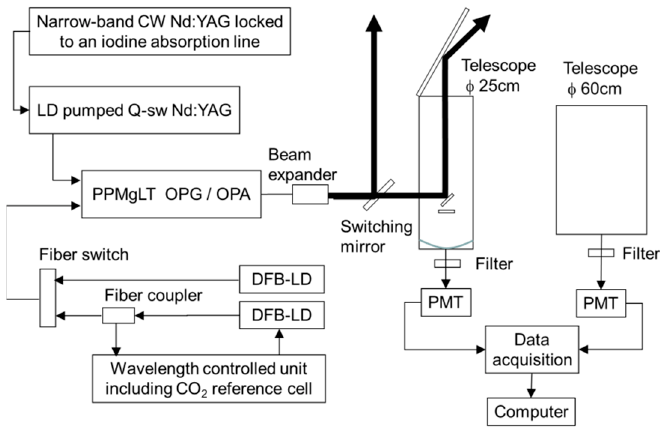
Figure 2. Block diagram of the 1.6 µ m DIAL system for measurement of CO 2 mixing ratio profiles. The low-altitude mode measurements were performed using a 25-cm-diameter telescope and the high-altitude mode measurements were done using a 60-cm-diameter telescope.